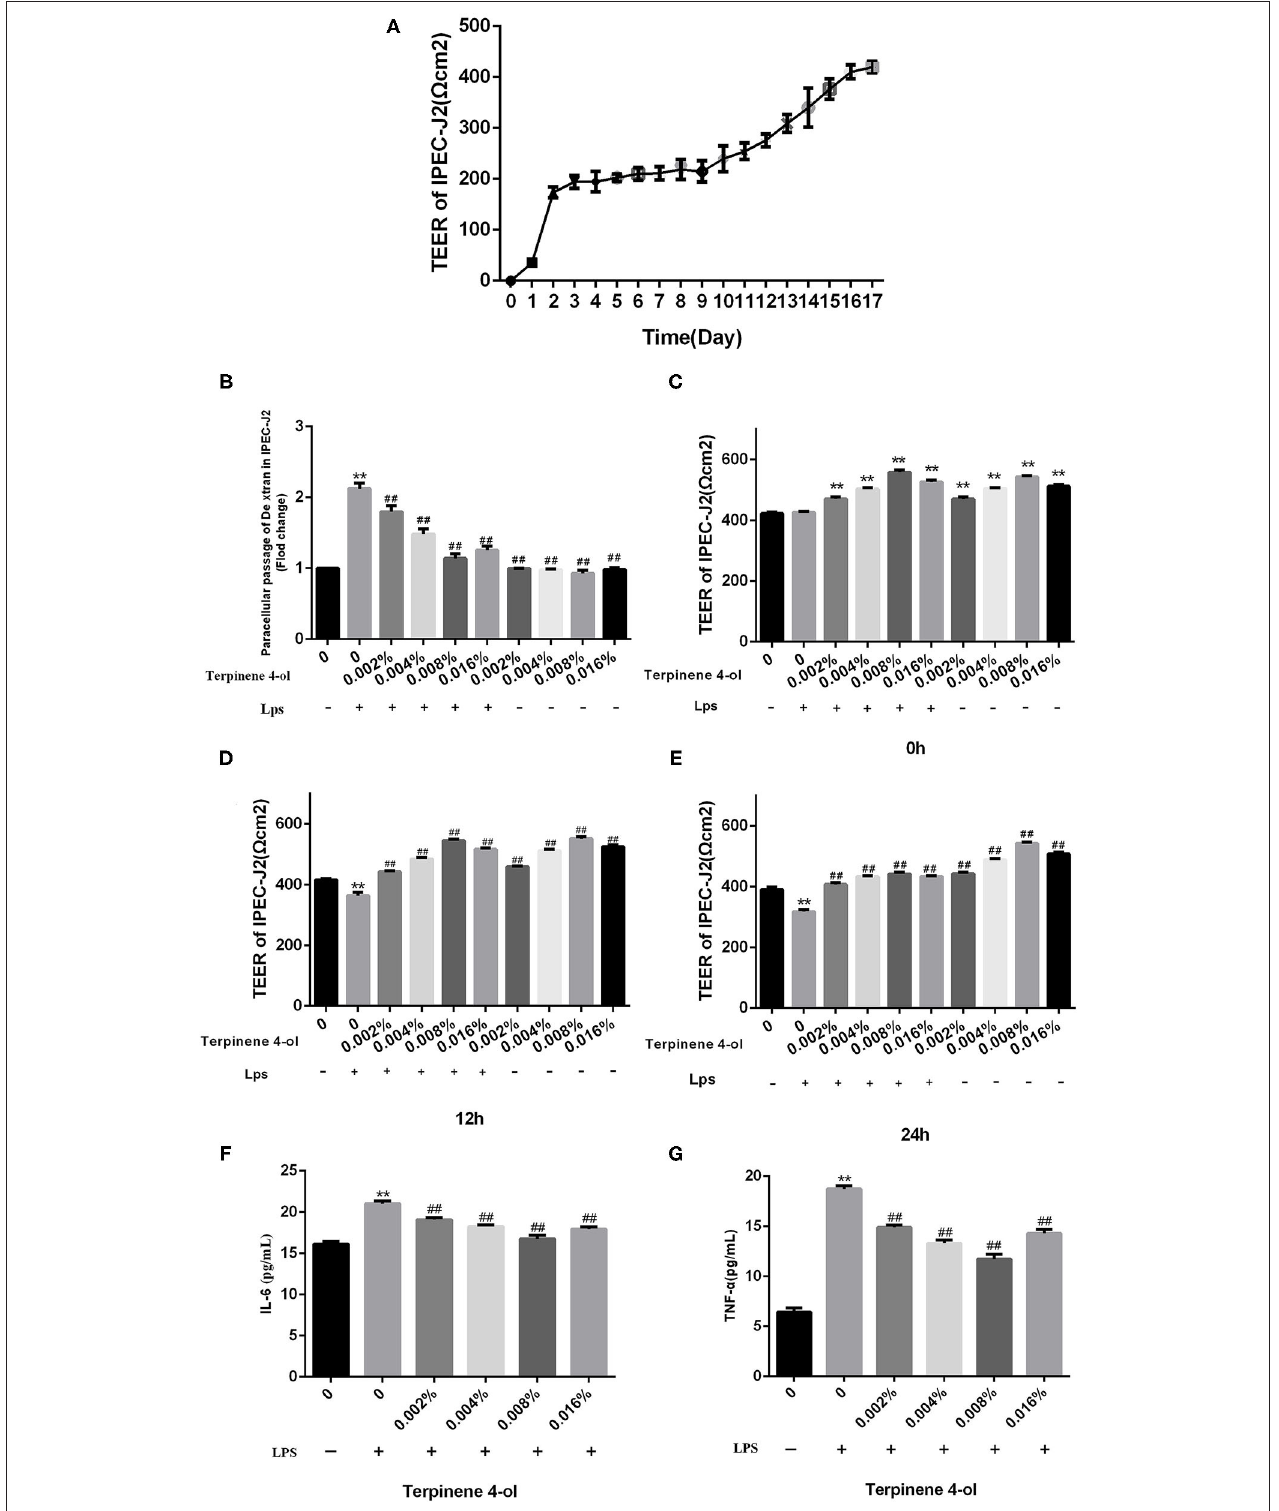
FIGURE 3 | Effects of TER on LPS-induced intestinal epithelial cell permeability and inflammatory cytokines. The protective effects of TER on fused monolayers of intestinal epithelial cells were examined by measuring the TEER values of fused intestinal epithelial monolayers at different time points and FITC-dextran